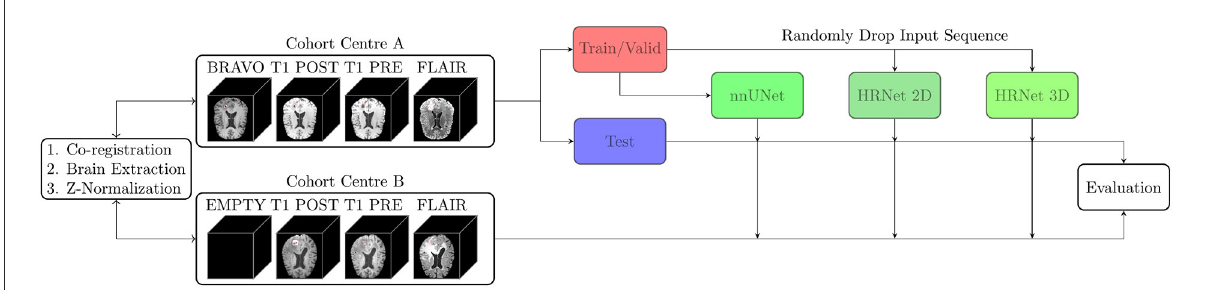
FIGURE1 Two patient cohorts from different institutions (A and B) were annotated by working radiologists, coregistered, and brain extracted. Cohort A was divided into a training/validation set and a test set, whilst cohort B was kept as an independent test set. Three models were trained on the training set from cohort A, and evaluated on the test set from cohort A and cohort B. Two of the models were trained with input-level dropout to allow for a variable number of input MR sequences.